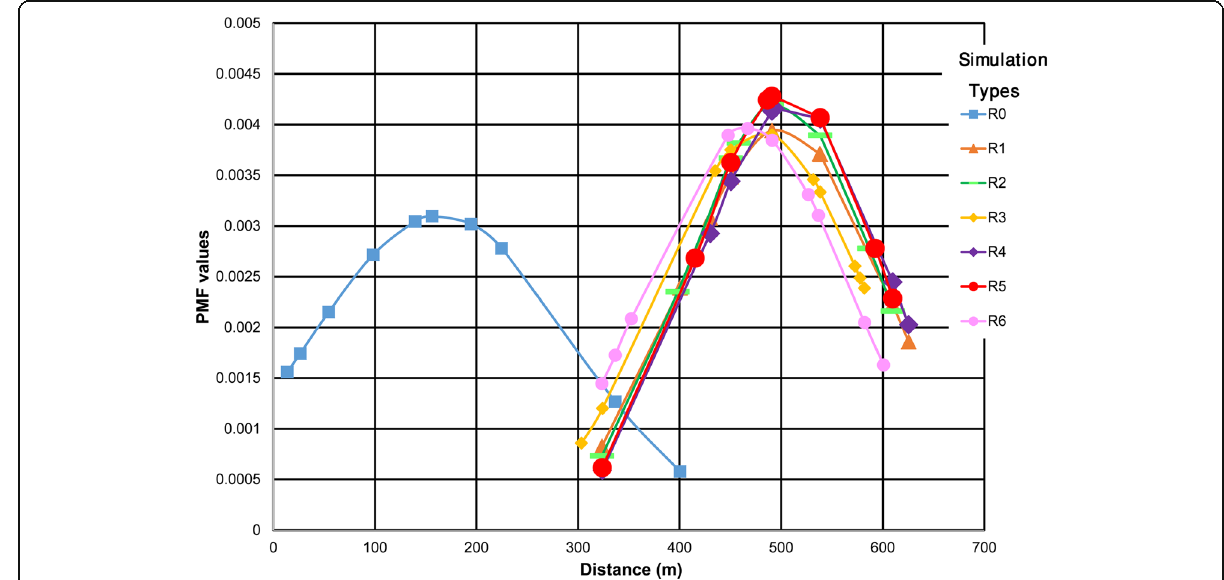
Fig. 13 Probability distribution chart of Plot